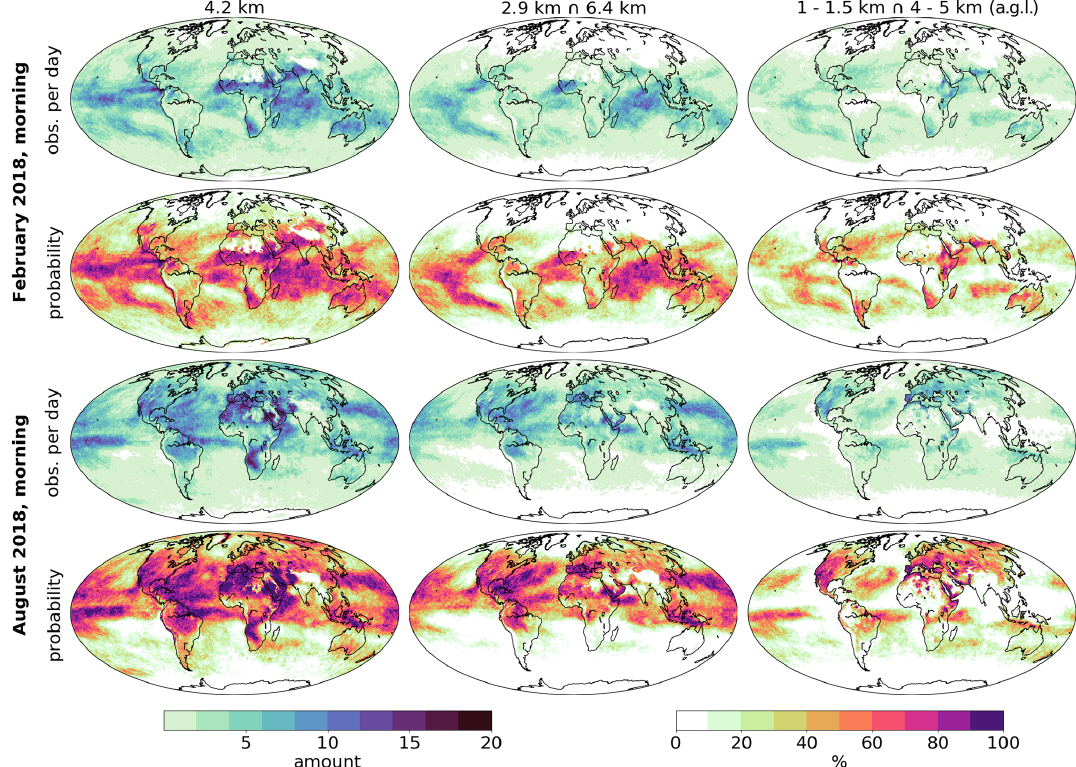
Figure 9. Monthly statistics for the horizontal availability of MUSICA IASI {H 2 O, δ D} pair data for February 2018 (first and second rows) and for August 2018 (third and fourth rows). Data are filtered according to Table 1. The first row for each month shows the averaged number of available observations per 1 ◦ × 1 ◦ grid box and per day, and the second row gives the frequency of days with at least one reliable observation inside a single 1 ◦ × 1 ◦ grid box. Shown are the results for observations at 4.2kma . s . l . (above sea level) in the first column and for observations fulfilling the quality filter conditions simultaneously at 2.9 and 6.4kma . s . l . (second column) and simultaneously at 1–1.5 and 4–5kma . g . l . (above ground level; third column). For the latter, if more than one grid level falls inside the given altitude range, then the lower one is chosen.